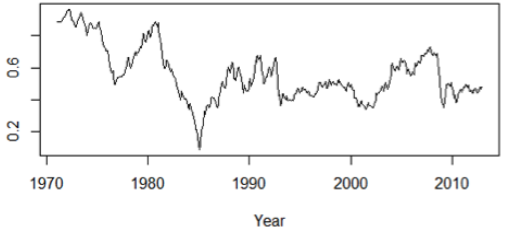
Figure 1: Time series plot of log ($/£)